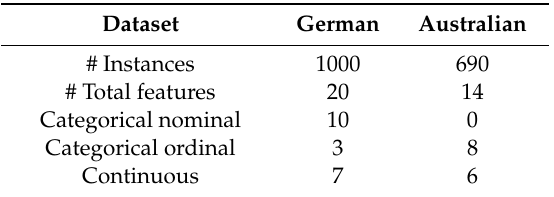
Table 3. Characteristics of the German and Australian credit scoring datasets.